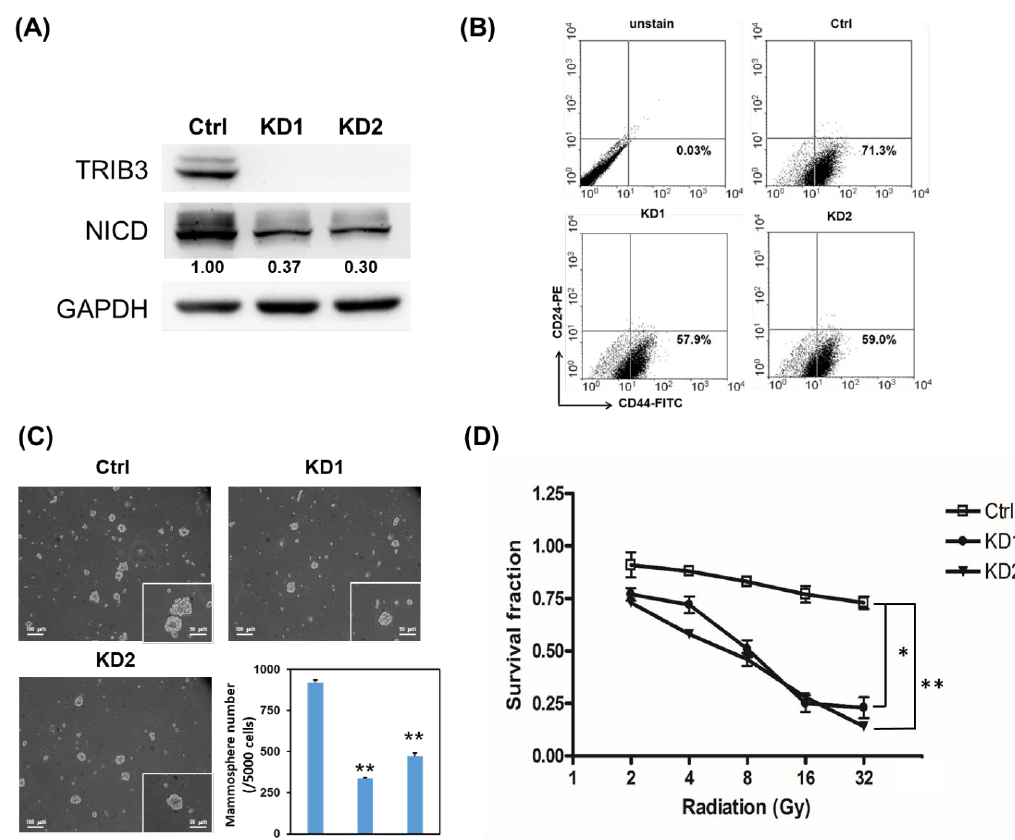
Figure 2. Knockdown of TRIB3 in radioresistant MDA-MB-231 cells reduced Notch1 activation and inhibited their cancer stem cell (CSC) activity. 231-RR cells were transduced with lentivirus carrying TRIB3 specific short hairpin RNAs (shRNAs) (KD1 or KD2) or control lentivirus (Ctrl, sh-LacZ) and selected for successfully transduced cells with 2 µ g/ml puromycin for 48 h. ( A ) The expression of TRIB3 and the Notch intracellular domain (NICD) in transduced cells was determined by Western blot. ( B ) The CD24-CD44+ cells in transduced cells were determined by flow cytometric analysis. ( C ) CSC activity of transduced cells was examined by mammosphere formation assay. ** p < 0.01. ( D ) The transduced cells were irradiated with indicated dosage and cultured for 96 h. Cell viability was determined with 3-(4,5-dimethylthiazol2-yl)-2,5-diphenyltetrazolium bromide (MTT) reagent and survival fraction was calculated by setting the absorbance at a 570 nm wavelength of non-irradiated cells as 1.0. * p < 0.05; ** p < 0.01.